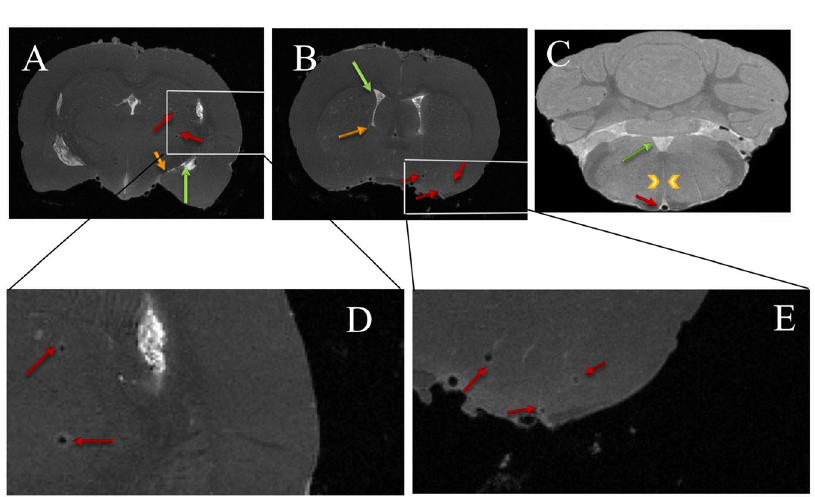
Figure 5. Perivascular tracer labeling and PVS connections between ventricles and brain parenchyma in individual image slices from the 3D image stack. ( A ) Ring enhancement around penetrating thalamic blood vessels (red arrows) showing the presence of tracer in PVS. Also shown are PVS around anterior choroidal artery (yellow arrow) connecting the lateral ventricle (green arrow) to the ventral brain surface. ( B ) Ring enhancement around vessels in cortex (red arrows) and PVS connections between lateral ventricle (green arrow) and caudate/putamen (yellow arrow). ( C ) Ring enhancement around the basilar artery (red arrow) and PVS around a paramedian branch of the basilar artery (yellow arrow head) connecting to the fourth ventricle (green arrow). ( D , E ) Enlarged sections of ( A , B ) outlined in white showing ring enhancement around blood